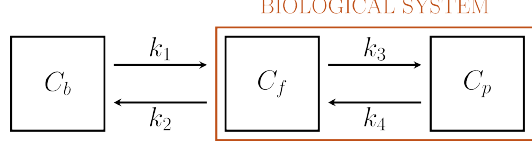
Figure 1. Standard Sokoloff’s 2-compartment